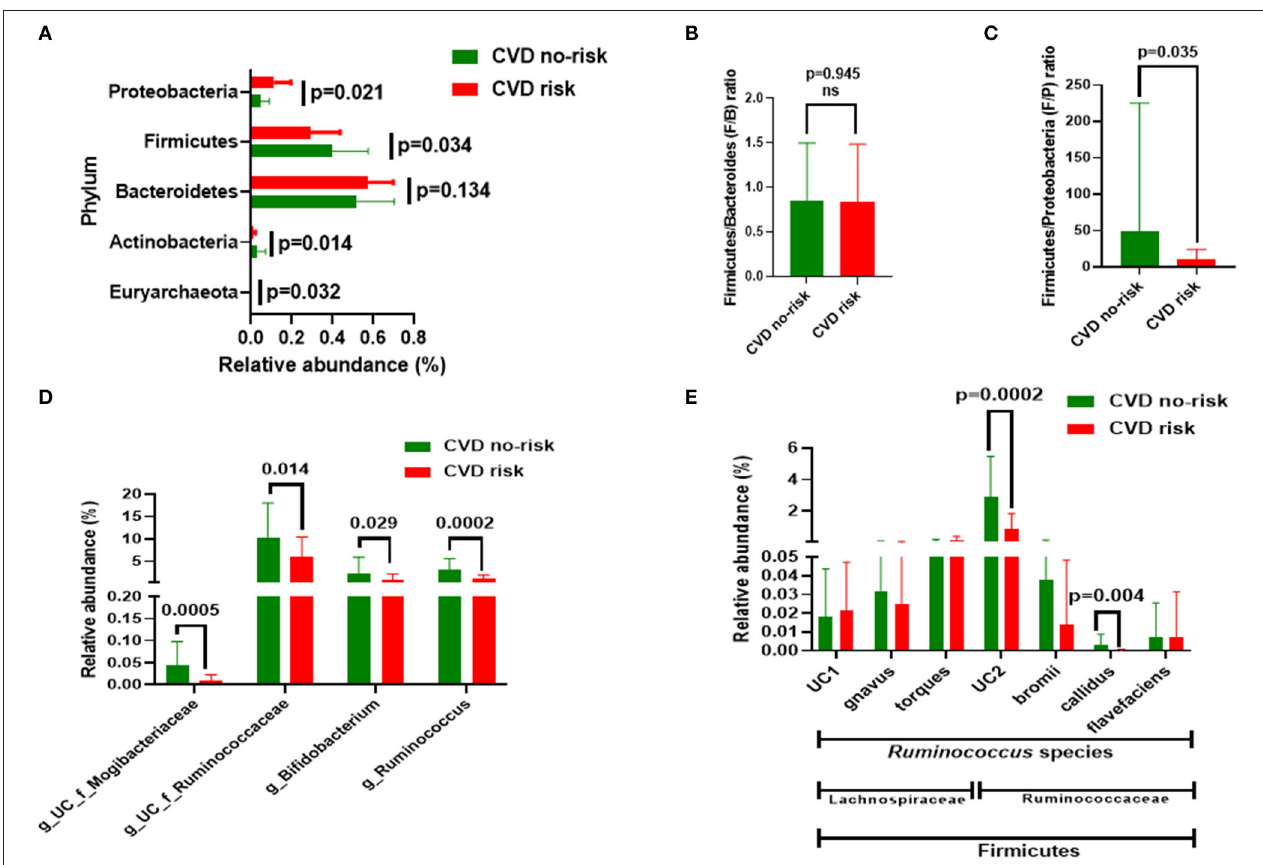
FIGURE 2 | Gut microbial composition in the CVD no-risk and CVD risk groups. (A) The four major bacterial phyla, except Euryarchaeota, were found in both groups. Data are shown as relative abundance (percentage of total gut microbiota composed of each phylum). (B,C) Ratio of Firmicutes to Bacteroidetes and Firmicutes and Proteobacteria, respectively, in the CVD no-risk and CVD risk groups. (D) Relative abundance of four major genera in the CVD no-risk and CVD risk groups. (E) Relative abundance of species of the Ruminococcus genus from the families of Ruminococcaceae and Lachnospiraceae in the CVD risk and CVD no-risk groups. The results are expressed as mean ± SD. CVD no-risk, N = 36; CVD risk, N = 10. P < 0.05 was considered statistically significant using Student’s t- test. “g_UC” and “f_UC” represent unclassified bacteria at the genus and family level,